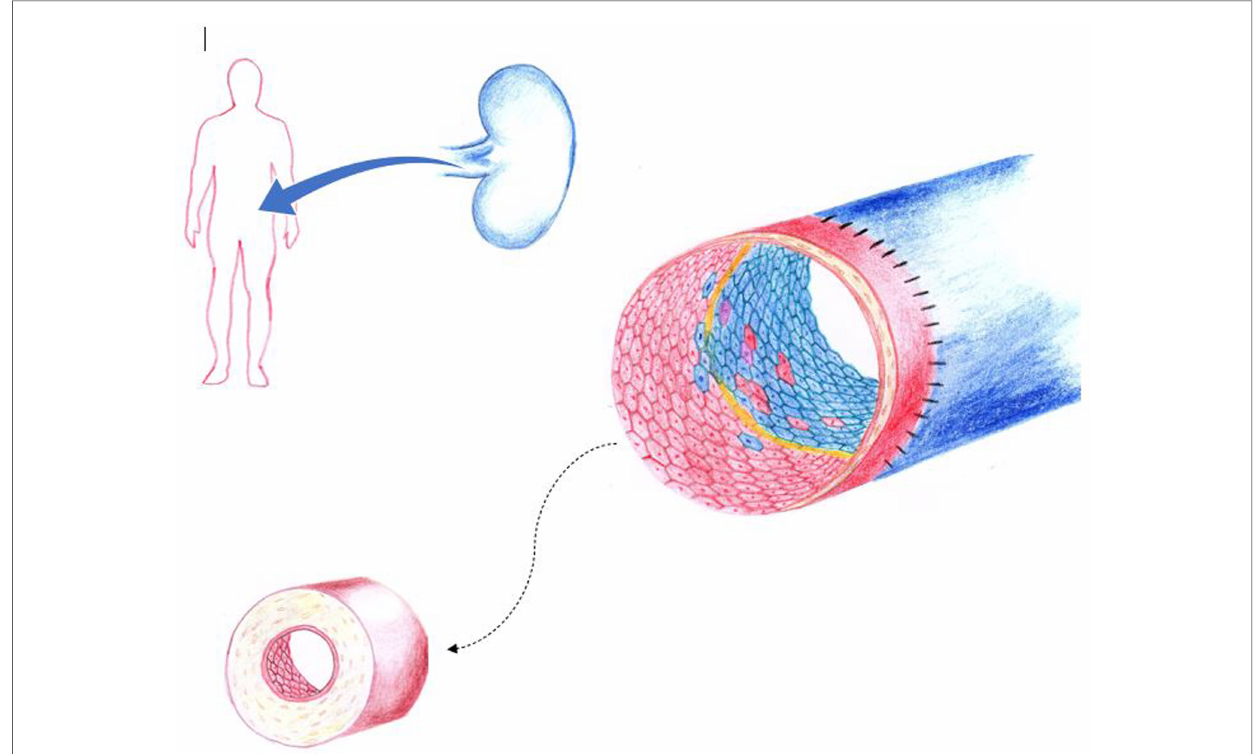
FIGURE 2 In solid organ transplantation, organ derived mature senescent donor endothelial cells are transplanted with the organ graft. Here, reverse endothelial chimerism occurs as recipient-derived cells replace the donor-derived endothelial cells within the vasculature of the grafted organ. At the zone of vascular anastomosis, exposed basement membrane (yellow) may also be reendothelized by donor graft endothelial cells (facilitated by cell-to-cell contact expansion). Blue, indicates of donor origin. Red, indicates of recipient origin. Purple represents monocyte to endothelial transformation or fusion cell phenomena. Chronic alloimmune injury leads to intimal thickening, accumulation of extracellular matrix, smooth muscle cell proliferation with resultant luminal narrowing. Here an indolent host versus graft reaction results in transplant vasculopathy that is associated with long-term organ loss. (Figure by S.